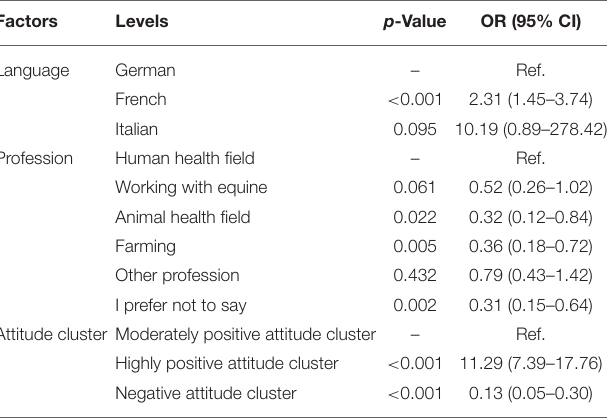
TABLE 3 | Factors influencing equine owner’s intentions to report to Equi-Commun, a community-based surveillance tool for equine health, resulting from a multivariable logistic regression analysis are